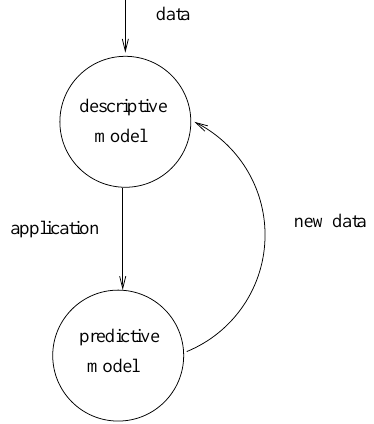
Fig. 1. The iterative process of descriptive and predictive modelling [1]. Descriptive phase analyses learners’ observation data and searches for correlations and association rules, and predictive phase generates the learner model. The same process can be used for context modelling. The descriptive model analyses data from the past or surroundings and pattern searching, like correlations and association rules, whereas the predictive model defines structure (variables and their